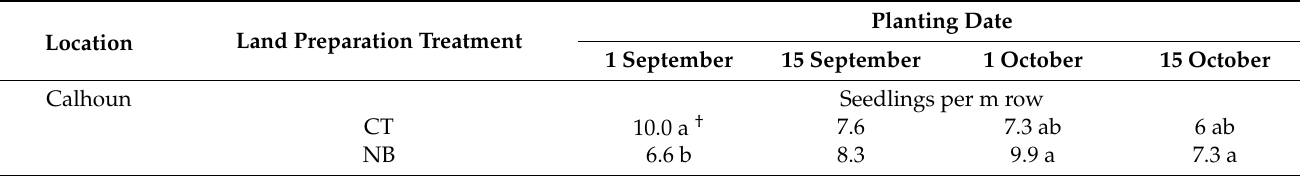
Table A1. Seedling count 14 days after planting for each combination of location, land preparation method, and planting date compared in the canola